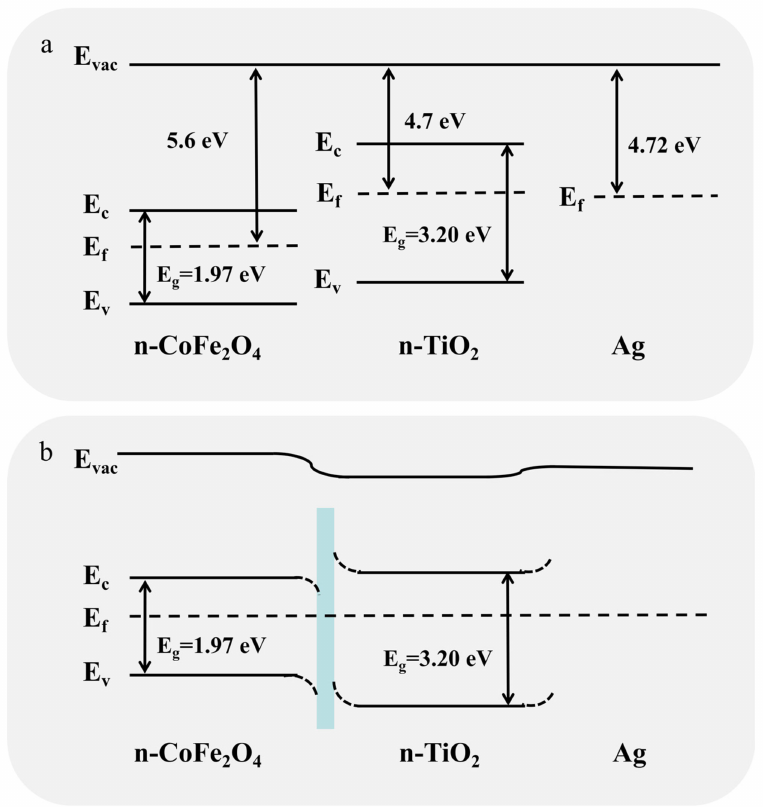
Figure 8. ( a ) Band structure diagram of TiO 2 , CoFe 2 O 4 , and Ag. ( b ) Band structure diagram of TiO 2 − CoFe 2 O 4 −